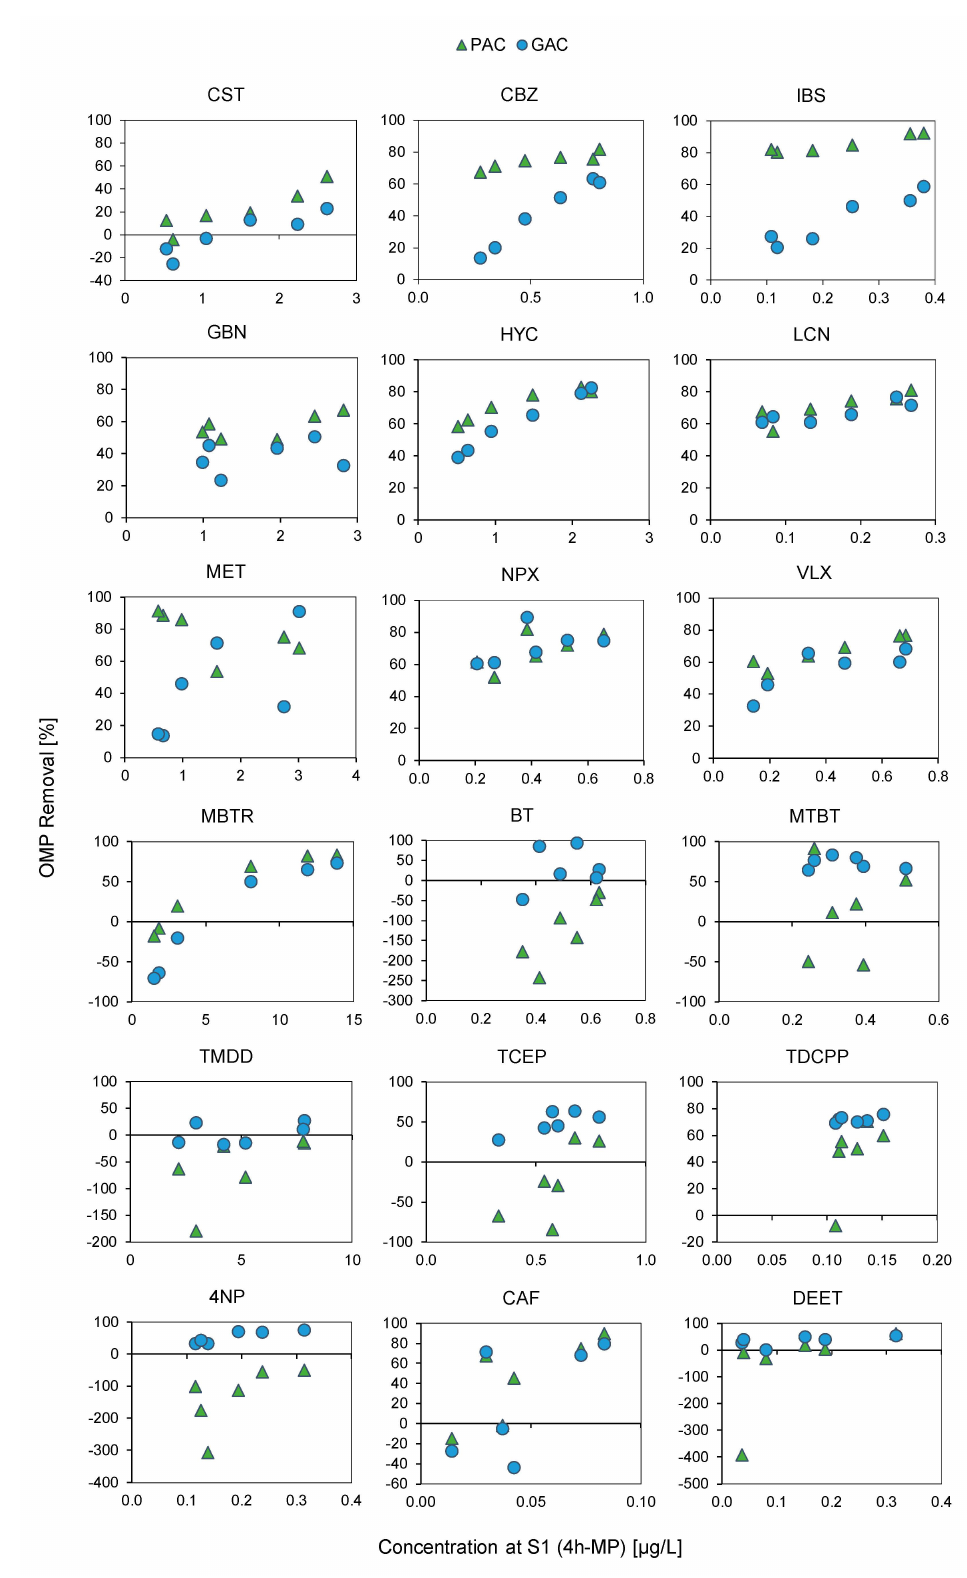
Figure A3. OMP removal in dependence of the inflow concentration (S1) for the treatment stages with PAC and GAC for WW2, Q PAC = 1402 − 1988 L/s, Q GAC = 141 − 181